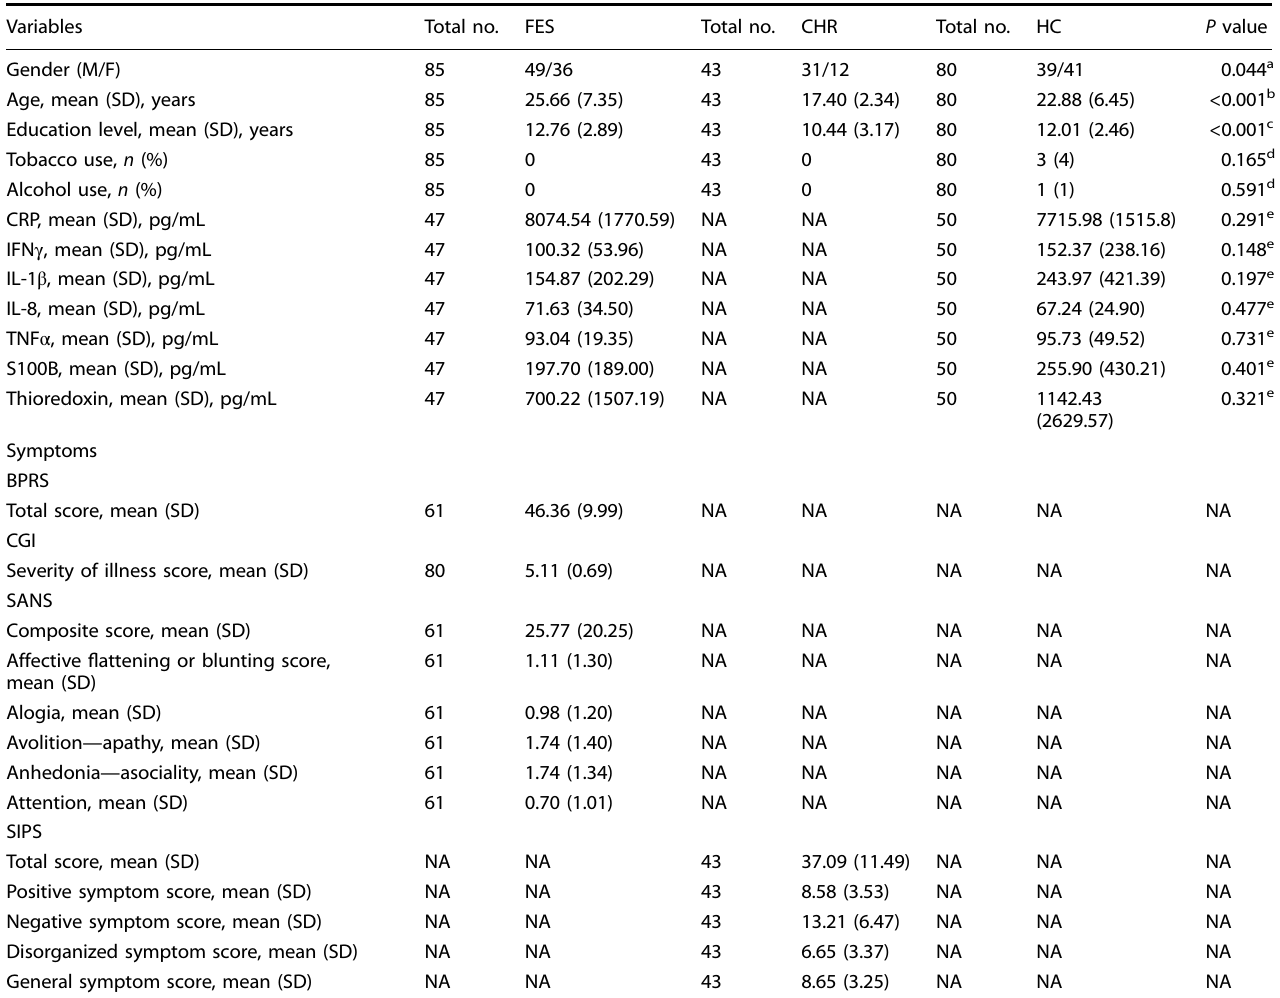
Table 1. Demographic characteristics of the study